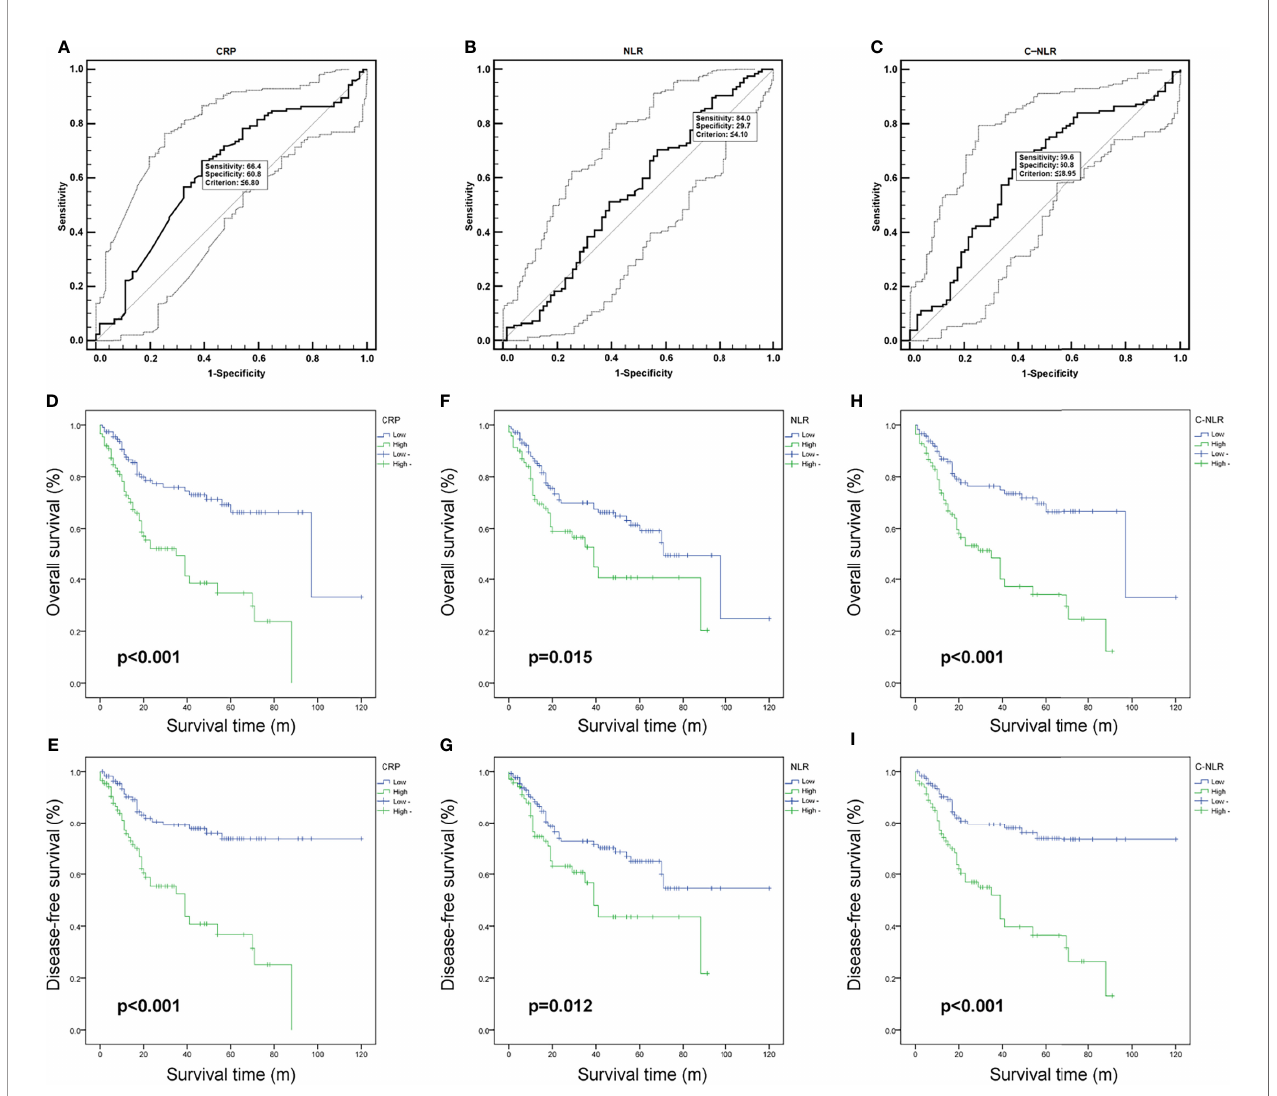
FIGURE 1 | The receiver operating characteristic (ROC) curves of C-reactive protein (CRP) (A) , neutrophil-to-lymphocyte ratio (NLR) (B) , and C-NLR (C) . Kaplan – Meier curves for overall survival (OS) and disease-free survival (DFS) after radical cystectomy strati fi ed by CRP (D, E) , NLR (F, G) , and C-NLR (H, I)